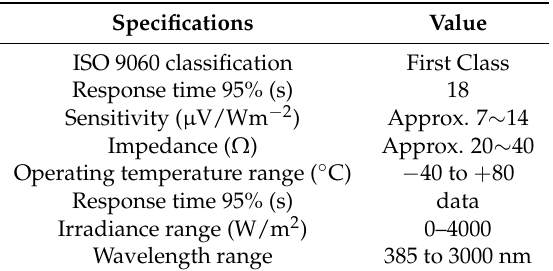
Table 1. Technical specifications of the used pyranometer.